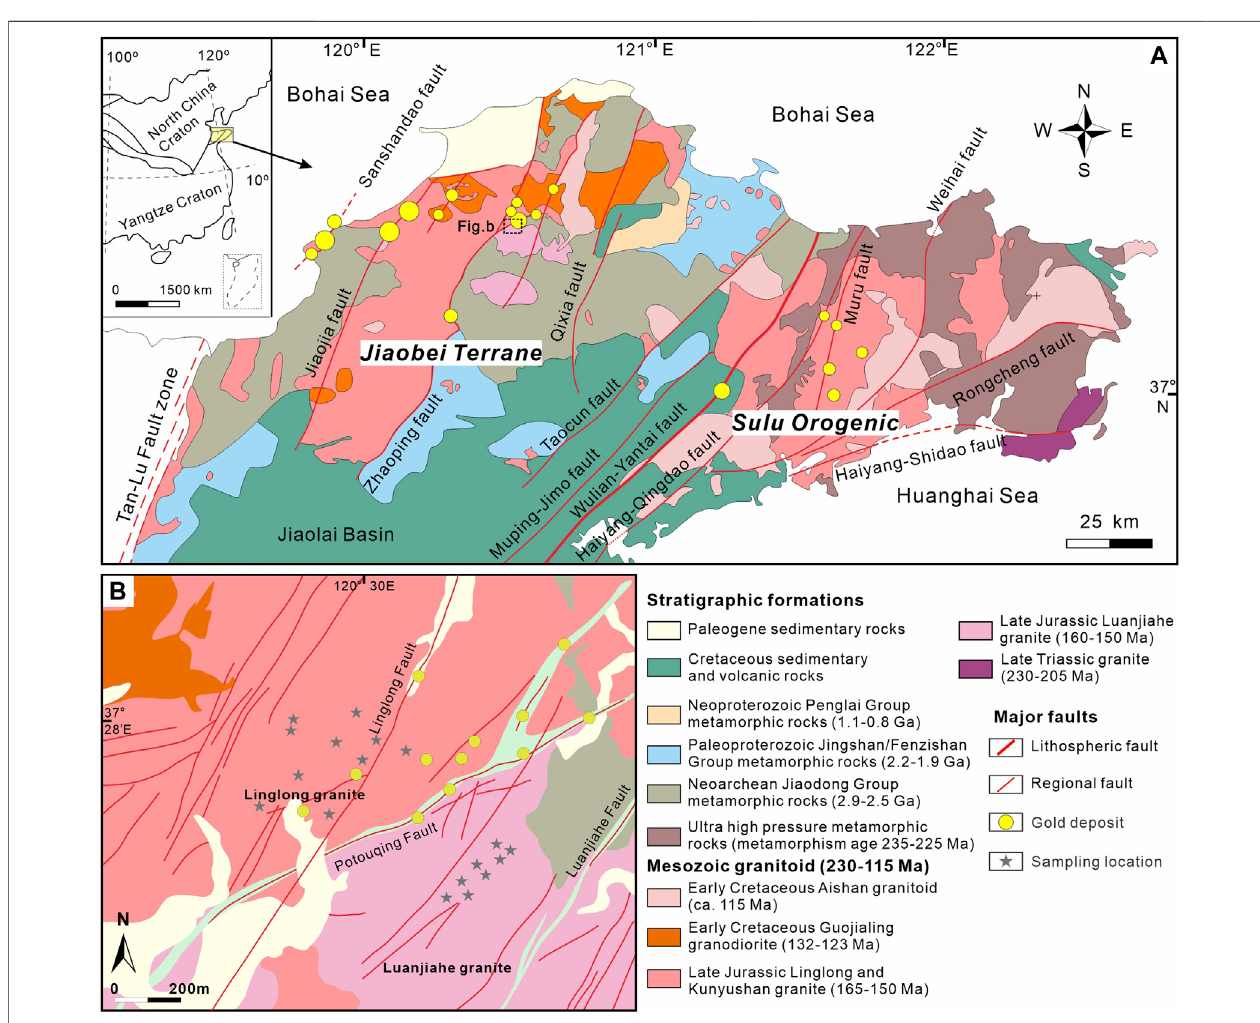
FIGURE1|(A) Simpli fi edgeologicalmapoftheJiaodongPeninsulaafterLiuetal.(2021) (B) GeologicalmapoftheLinglongoredistrict,showingthedistributionof the Linglong and Luanjiahe granites and sample locations.